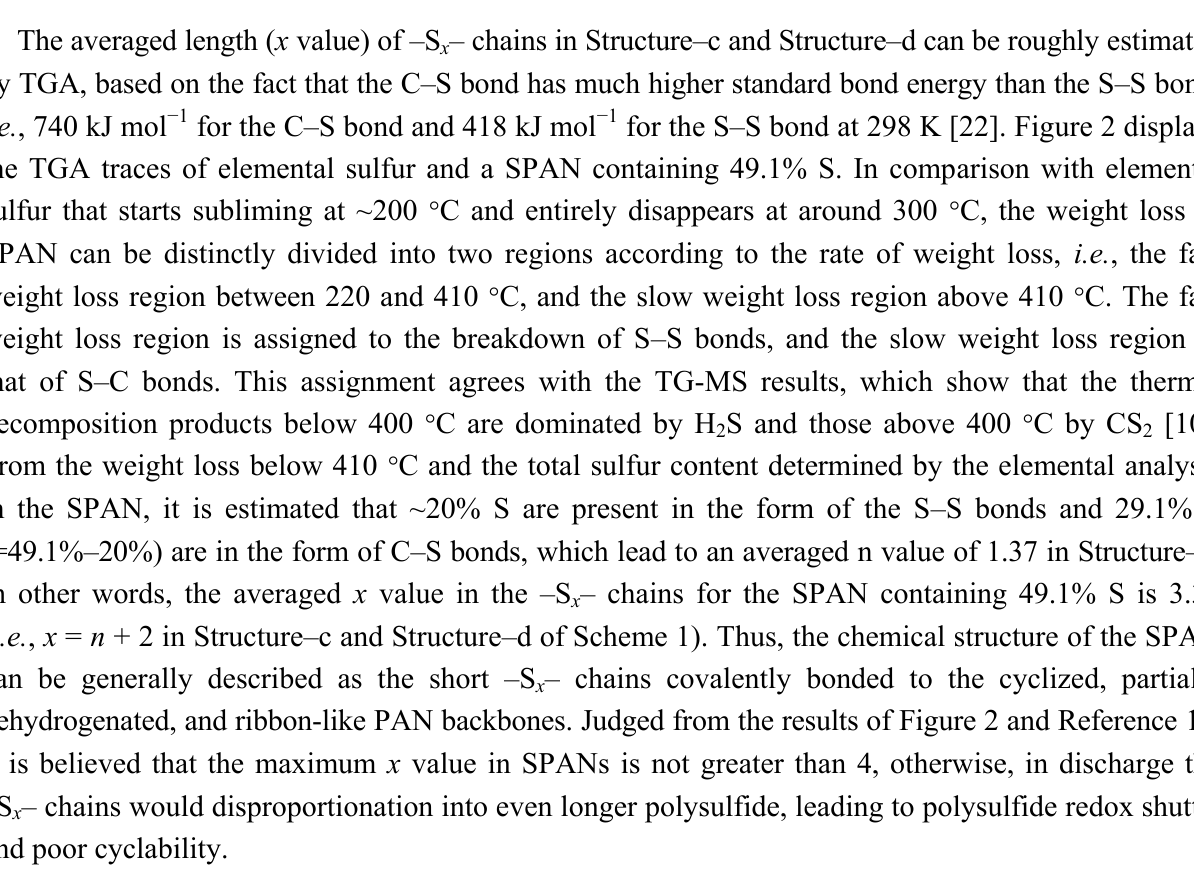
Figure 2. thermogravimetric analysis (TGA) traces of elemental sulfur and SPAN (49.1% S), made by heating a 4:1 (wt) S/PAN mixture at 300 °C for 4 h. Plotted from the data of